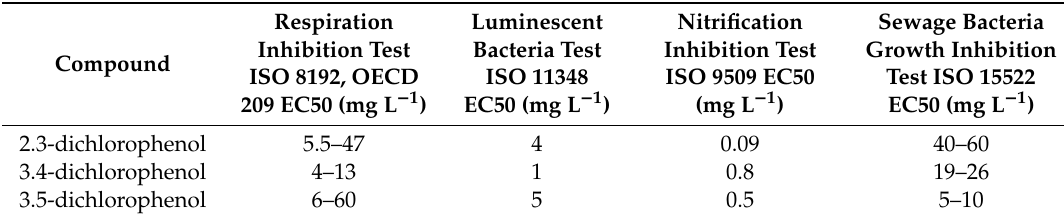
Table 6. Toxicity data for di ff erent dichlorophenols from ISO and OECD normalized bacterial toxicity tests. The data originate from this and former studies